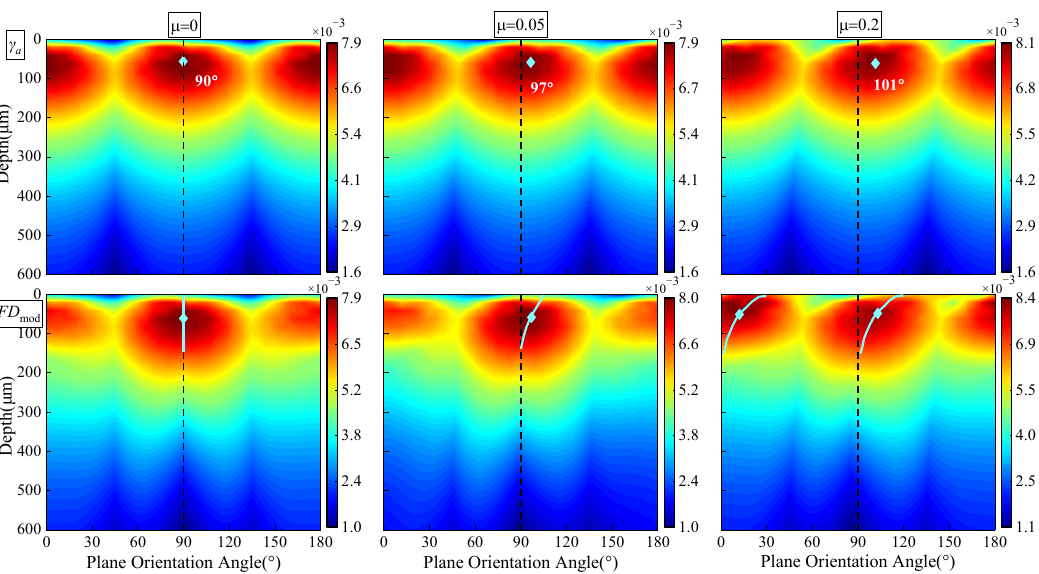
Figure 18. Variation of a and FD mod under different lubrication conditions ( T out = 800 N m, P h = 1.56 GPa).